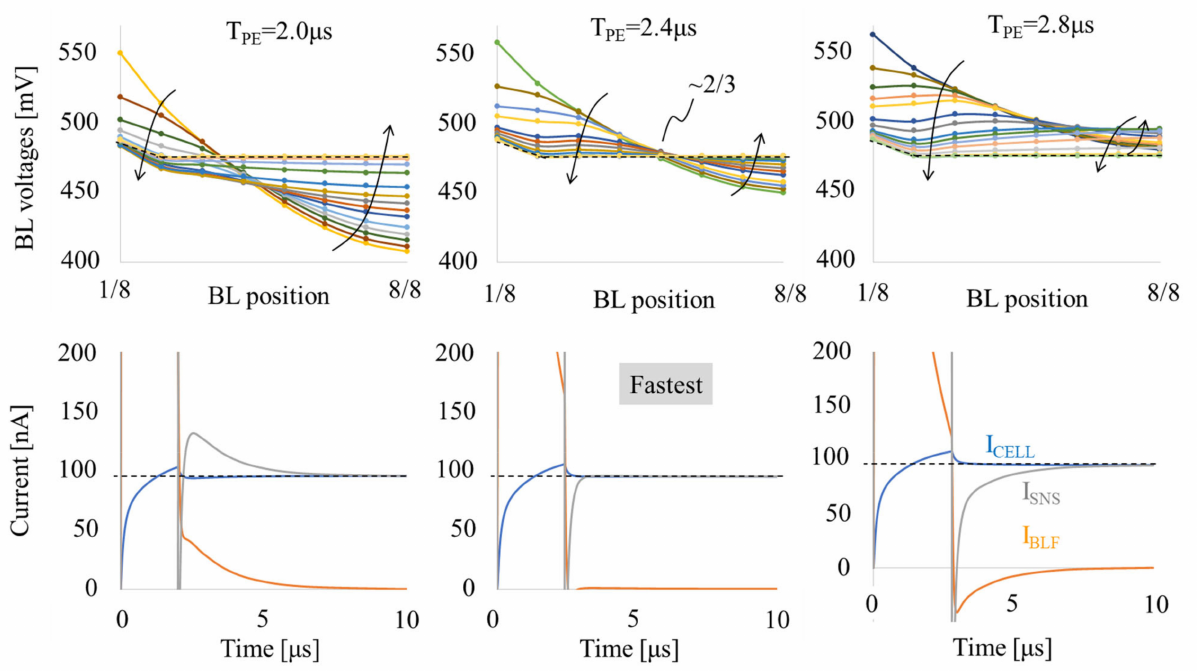
Figure 6. BL voltage ( upper ) and current waveform ( lower ) with different Tpre (2.0 µ s, 2.4 µ s and 2.8 µ s from left to right, respectively) values when the “1” cell at x = 25% is